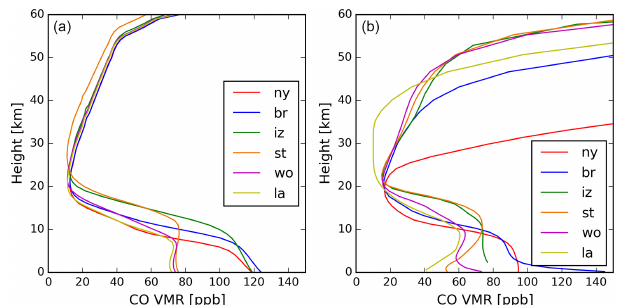
Figure 3. The CO a priori VMR profiles for TCCON (a) and NDACC (b) at six sites (ny: Ny-Ålesund; br: Bremen; iz: Izaña; st: Saint-Denis; wo: Wollongong; la: Lauder). As TCCON a priori profiles change every day, the mean profiles in 2013 are shown